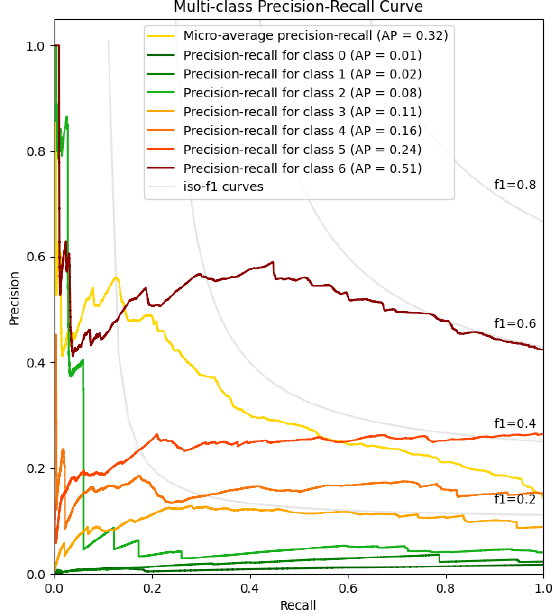
Figure 15. Multiclass precision–recall